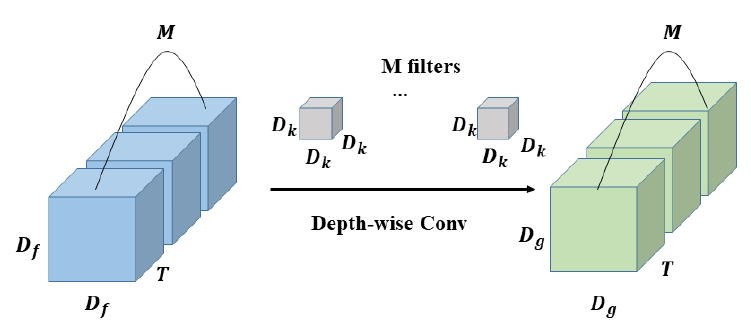
Figure 7. The process of 3D depth-wise convolution.